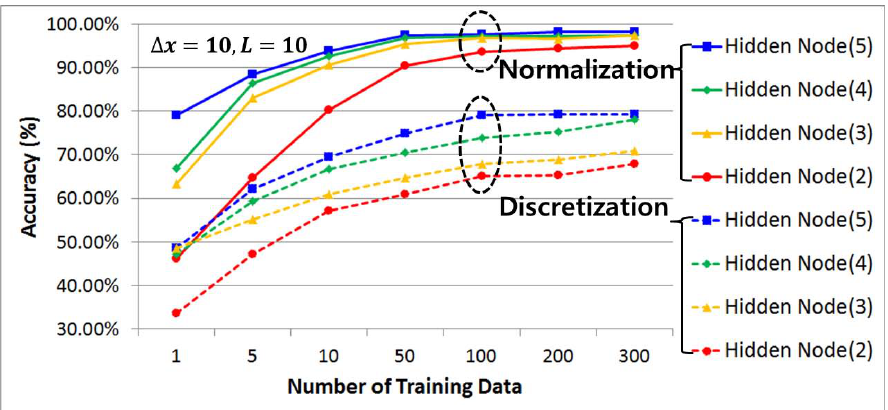
Figure 15. ( ∆ x = 10, L = 10) Comparative analysis of prediction accuracy per data preprocessing technique using historic data, the number of hidden layers, and the number of training data.